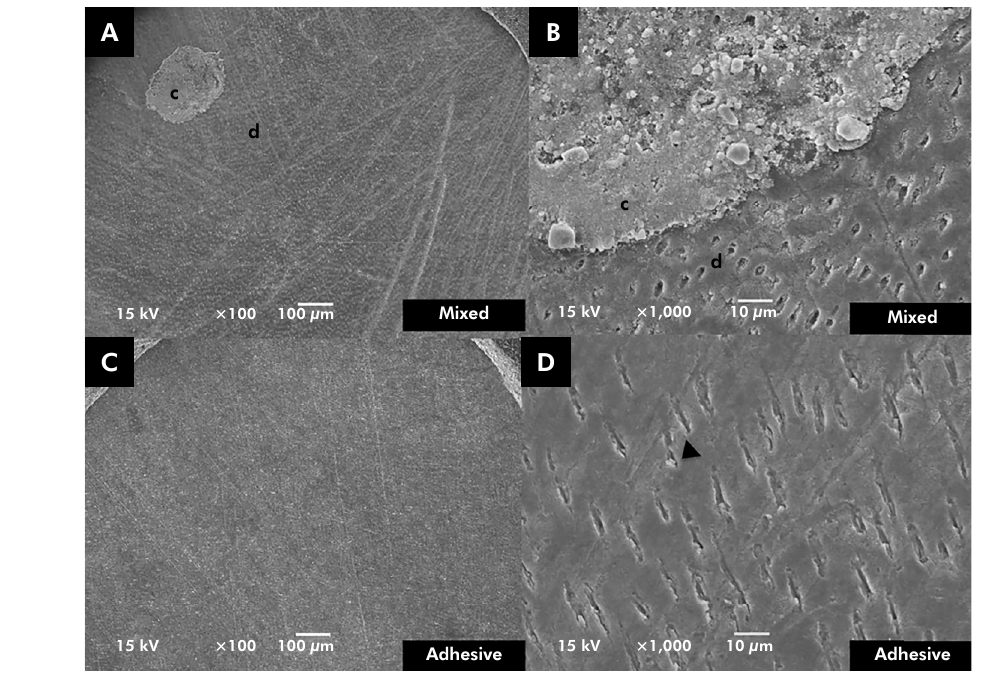
Figure 7. SEM micrographs of SE adhesive system debonded specimens. Images A and B (1CQ:1TPO) show mixed failure, with remnants of resin composite (c) attached to dentin (d). Images C and D (1CQ:3TPO) show adhesive failure with dentin tubules containing adhesive